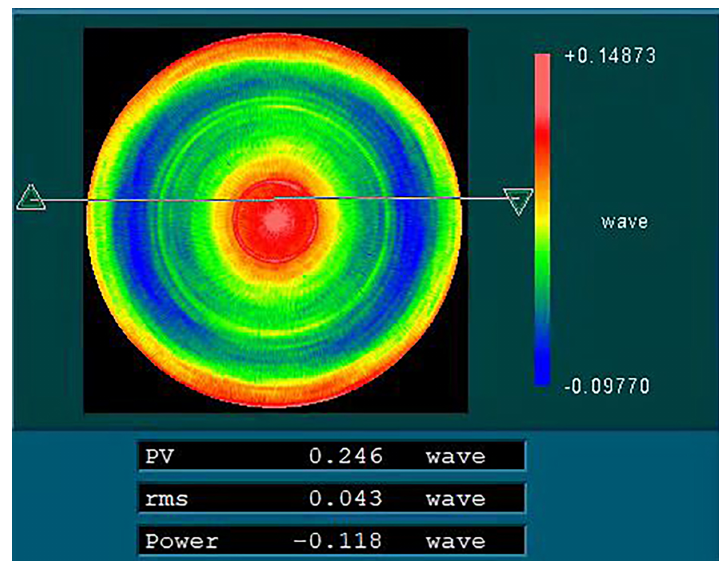
Figure 15. The test of the influence of gravity on surface-shape